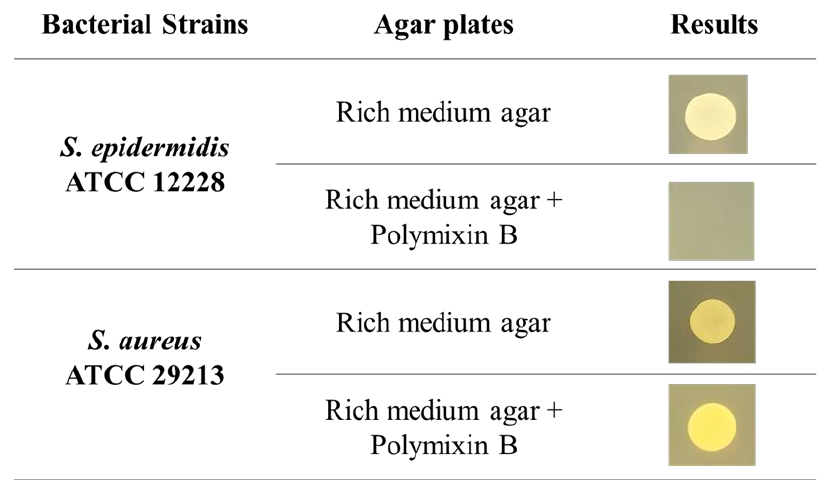
Figure 1 : The spot-appearances of S. epidermidis and S. aureus on Rich medium agar and selective Rich medium agar + Polymyxin B agar plates. The clustered S. epidermidis and S. aureus grew well on rich medium agar. When Polymyxin B (100 μg/ml) was added t o the agar, S. aureus still occurred while S. epidermidis disappeared. Rich medium agar + Polymyxin B (100 μg/ml) was selected as S. aureus selective